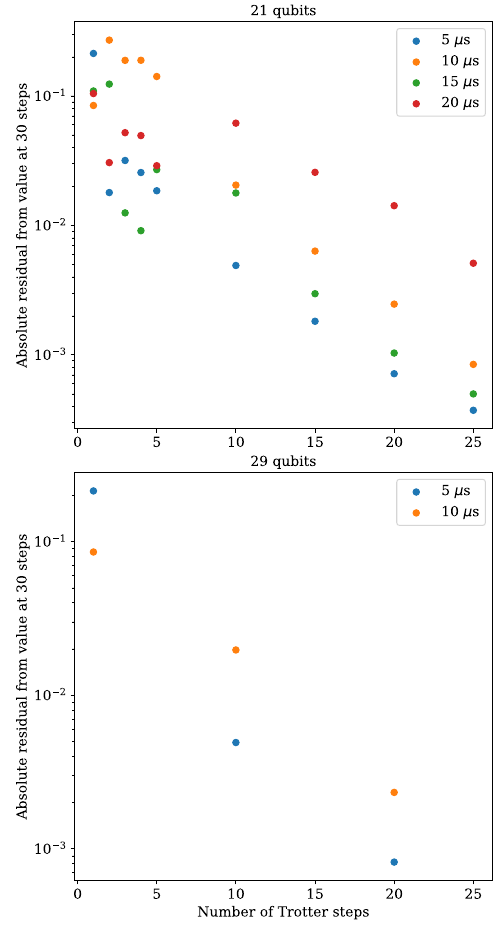
FIG. 9. Convergence of the Trotter error for both the 21- and 29-qubit systems, as a function of the number of Trotter steps used. As these systems are too large to exactly simulate classically, we are unable to calculate the Trotter error in the polarization function. As a result, we plot how the polarization converges towards the value at 30 Trotter steps (which may still be far from the true